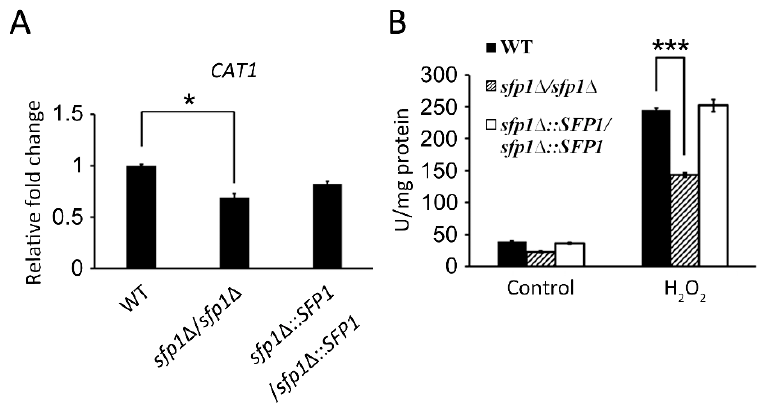
Figure 5. Catalase gene expression and enzyme activity. ( A ) The expression level of the CAT1 gene was detected using real-time qPCR. The PMA1 transcript was used as an endogenous control. ( B ) Cells were treated with 1 mM H 2 O 2 for 2 h, and catalase activity was determined. The results are presented as the mean ± standard deviation (SD) of three independent experiments. *** P < 0.001; * P < 0.05.